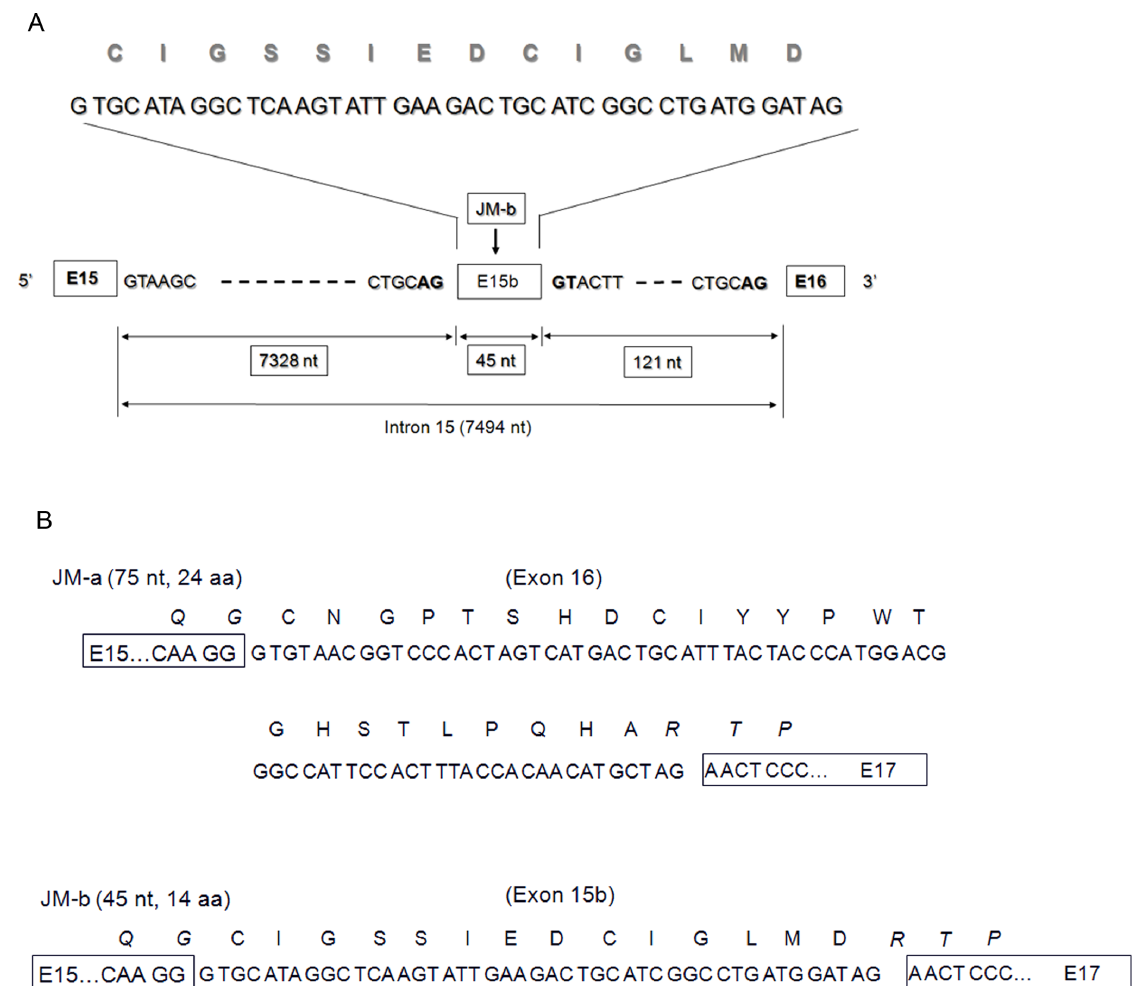
Figure 3. A. Partial exon-intron structure in a region of the ErbB4 gene containing exon 15, intron 15, and exon 16. The 45-nt sequence unique to the JM-b isoform maps to the 3 9 region of the intron 15, 121-nt upstream of exon 16 of the ErbB4 gene. Exons 15, 15b and 16 are shown, respectively. Partial intronic sequences, downstream of the exon 15, upstream of the exon 16, as well as upstream and downstream of the exon 15b are shown. Dashed lines represent intron 15 sequence. The 14 aa encoded by the 45-nt sequence, specific for the JM-b isoform, is shown. The length of the intron 15 of the ErbB4 gene is indicated. B. Comparison of JM-a and JM-b sequences showing the nucleotide sequences specific for JM-a or JM-b isoform and amino acids encoded by each exon. The glycine residue maps to the end of exon 15 of human ErbB4 sequence NM_005235.2. The first cysteine is common to both JM-a and JM-b but is encoded by different nucleotide sequences belonging to exons 16 and 15b,